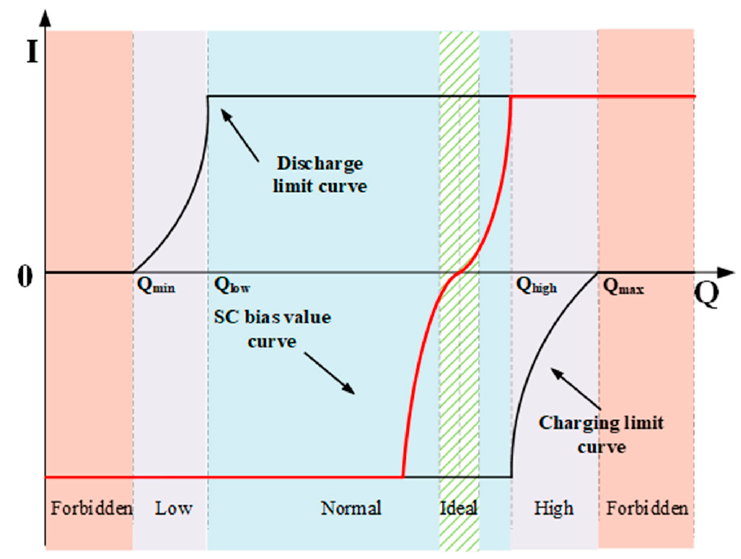
Figure 7. Bias power calculation and dynamic limiting.